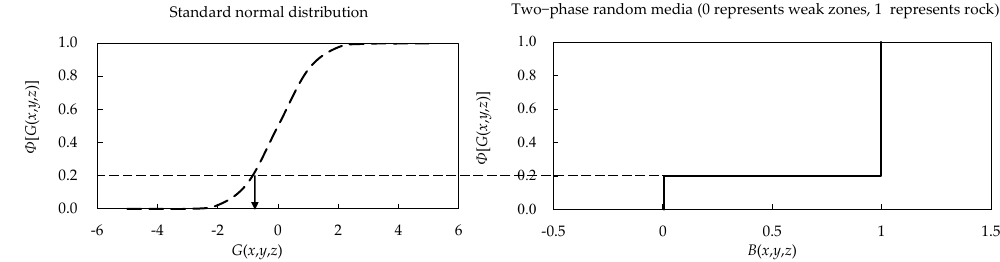
Figure 1. Reconstructions of two-phase random media on the basis of the volume fraction of weak zones and rock.